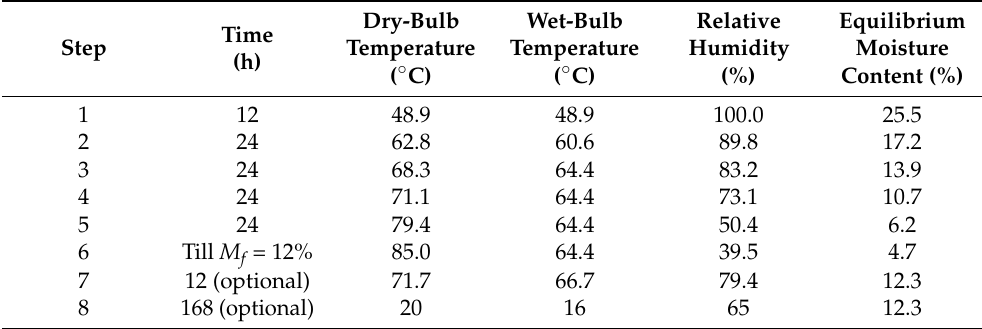
Table 4. Second modified schedule. This schedule comprises five time-based steps and one moisture- based step, followed by optional conditioning (step 7) and optional post-storage (step